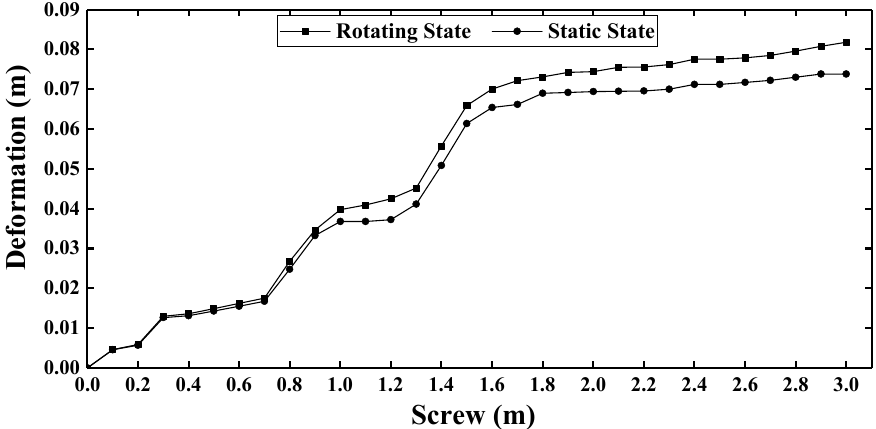
Figure 13. The radial deformation of the lead screw without a support slider.